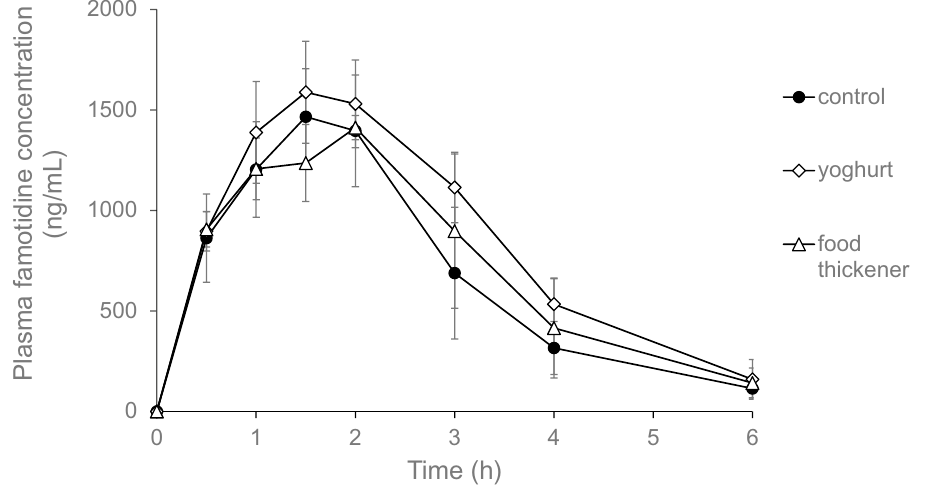
Figure 2. Plasma famotidine levels in rats orally administrated famotidine powder mixed with swallowing aids. Plasma famotidine levels were measured at 0.5, 1, 1.5, 2, 3, 4, and 6 h. Control: rats administered famotidine powder with water; Yoghurt: rats administered famotidine powder mixed with yoghurt; Food thickener: rats administered famotidine mixed with food thickener. Data are expressed as means ± SD for five rats. There was no significant difference between groups in each time point using one-way ANOVA.